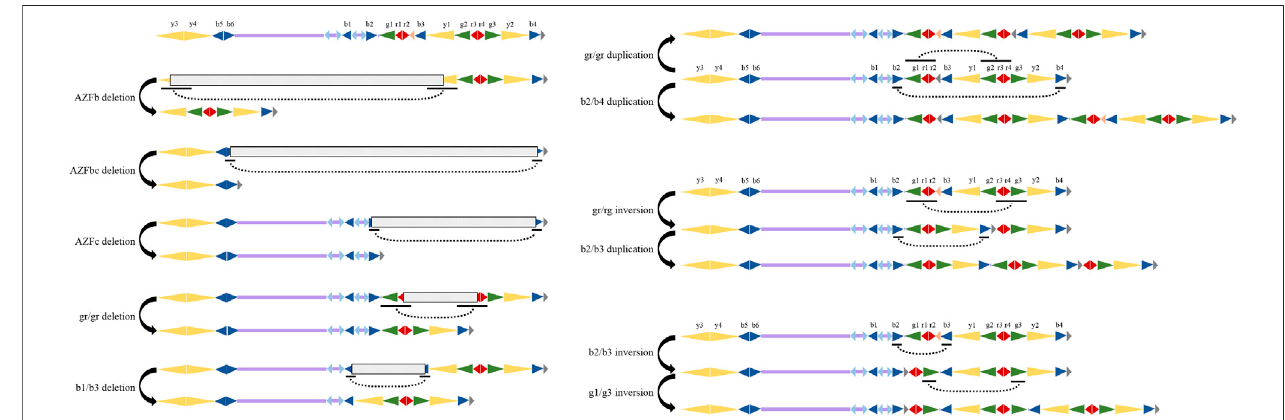
FIGURE2| CNVinAZFbandAZFcoftheYChromosome.Repeatingunitsarerepresentedbyarrowsofdifferentcolours,andthesizeandtranscriptionaldirection ofthe amplicons arerepresentedbythelengthand direction ofthearrows. Theleftcolumnisthe deletion type, and the rightcolumnisthe inversion and duplication. The dashed curve indicates the position of the recombination. The shaded block describes the location of the deletion. Map information is adapted from published